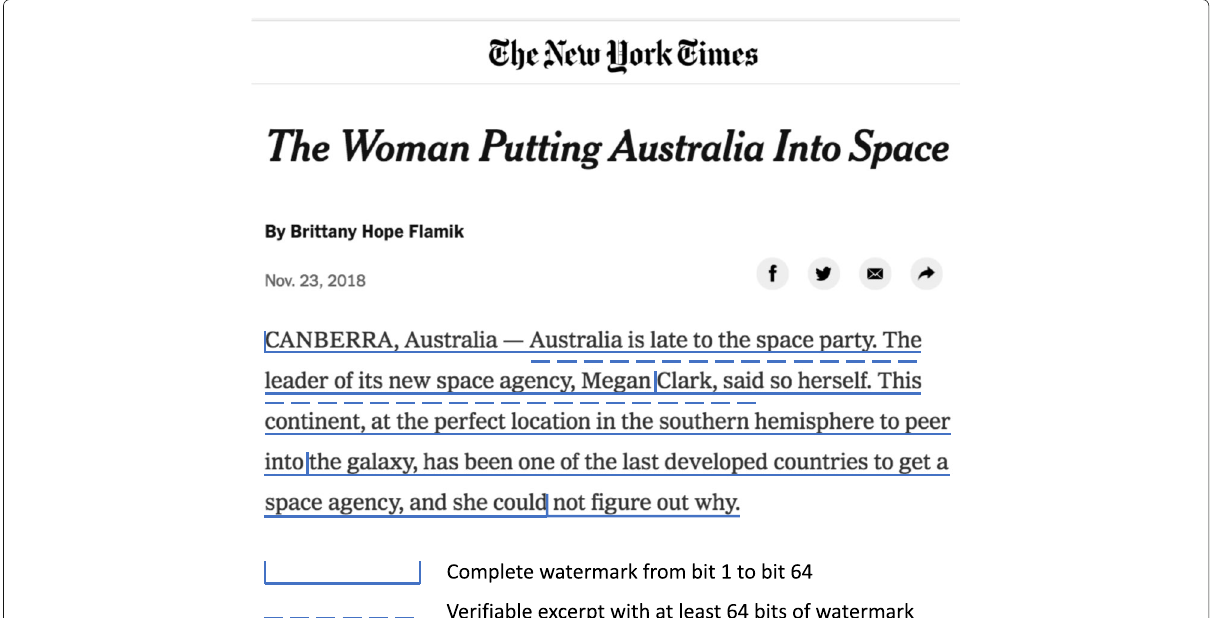
Fig. 6 Excerpt example from NYT article. The continuous lines limit complete 64 bits watermarks. Underlined with a dashed line is an example of verifiable excerpt spanning across two complete watermarks